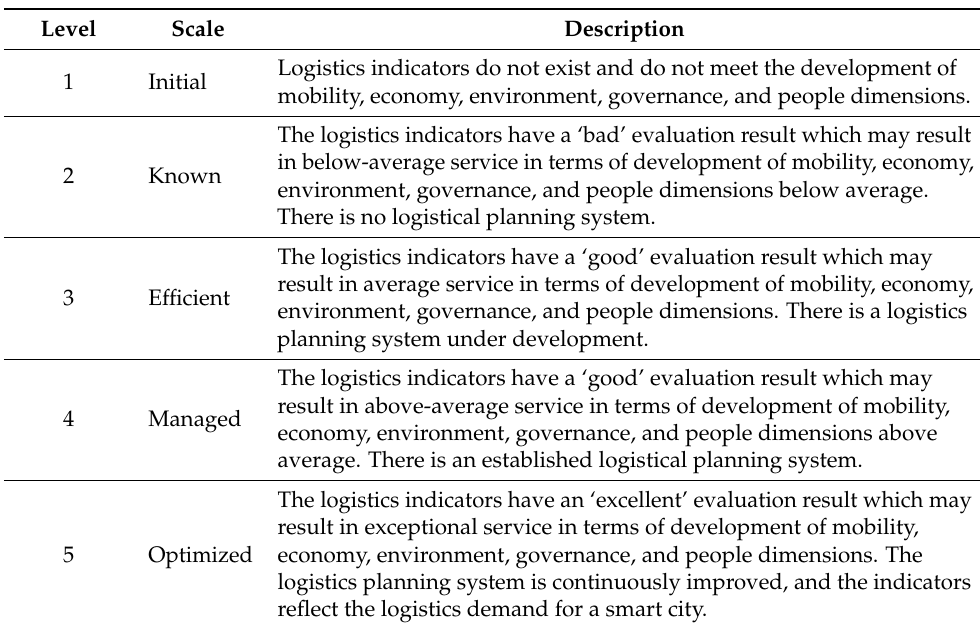
Table 2. Scale with the logistical maturity levels description in smart cities (results of the third Delphi round).